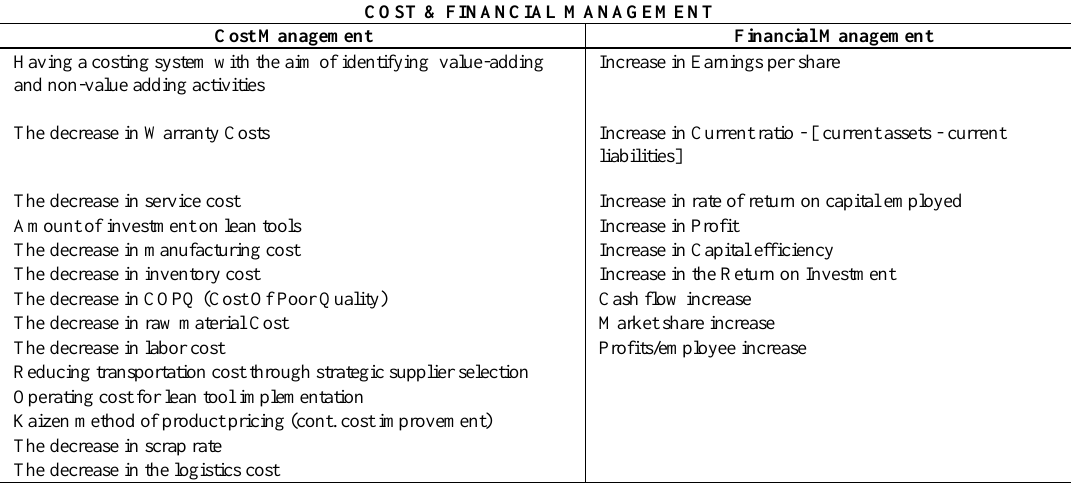
Table 7. Sub-criteria and measures for the cost & financial management main